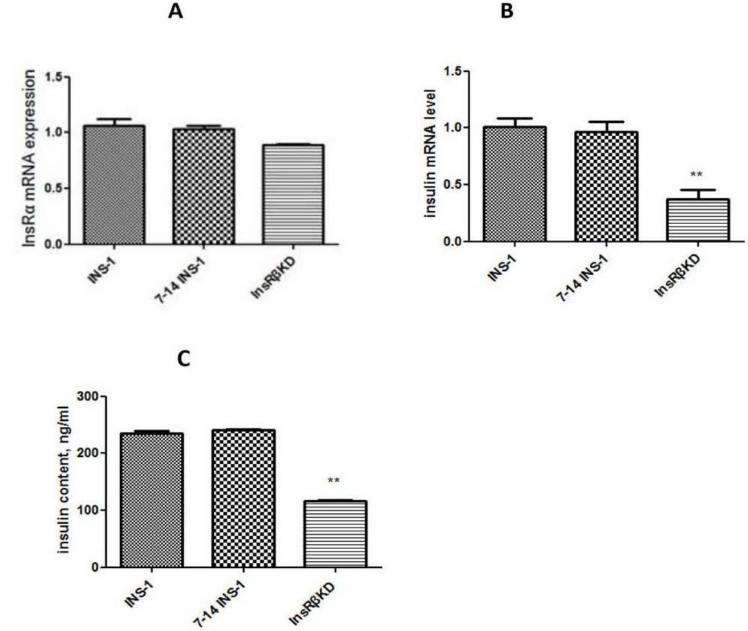
Figure 5. InsR α and insulin mRNA expression, and insulin content in transduced cells. InsR α ( A ) and insulin ( B ) mRNA expressions were measured using qPCR. The mRNA expressions were normalized to that of GAPDH and then to that of INS-1 cells. ( C ) ELISA result of insulin levels in INS-1, 7-14 INS-1, and InsR β KD cells. InsR β KD cells showed a reduction of insulin levels compared to the controls. ** p < 0.01, n =